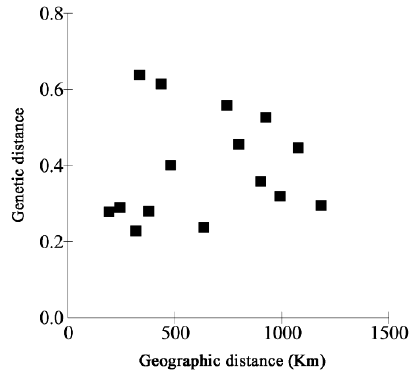
Figure 1. Relationship between genetic and geographic distance in the populations of C. tsoongiana .